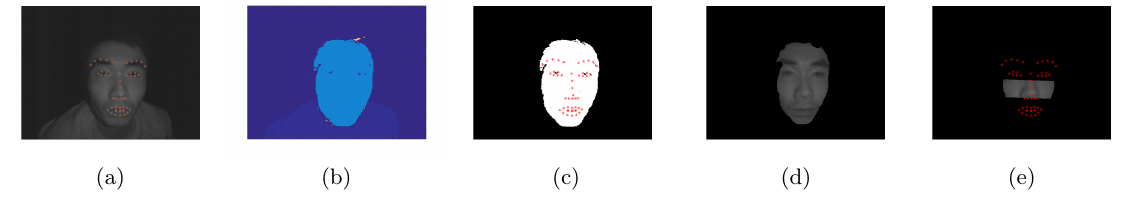
Figure 4: Cheek region segmentation using infrared and depth image. (a) Facial landmarks tracked on infrared image. (b) Connected components in depth image. (c) The connected component containing the most landmarks is selected as the face. (d) Face region in infrared image. (e) Cheek area is selected as the region between the eyes and mouth landmarks.